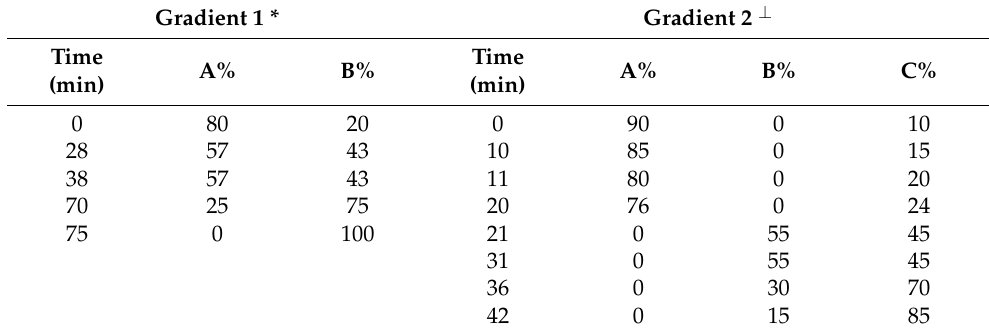
Table 1. HPLC gradient conditions of method 1 (gradient 1) and method 2 (gradient 2).